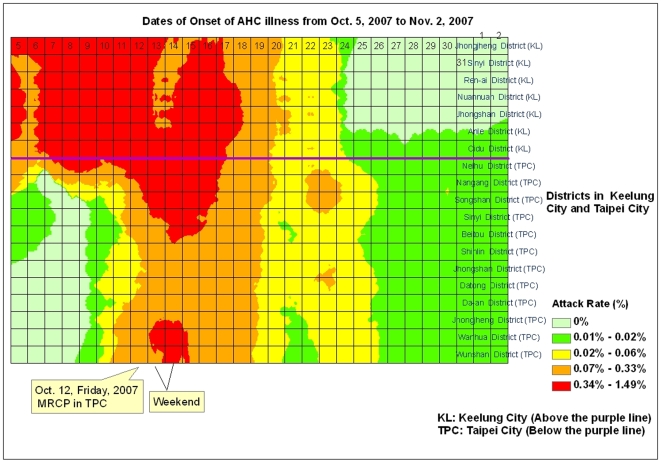
Spatio-temporal Diffusion Patterns of AHC Outbreaks from Keelung City to Taipei City, 2007.The X-axis reflects the temporal scale, while the Y-axis displays district names ordered by geographical correlation from North to South, East to West. The horizontal purple line marks the border between Keelung City and Taipei City.